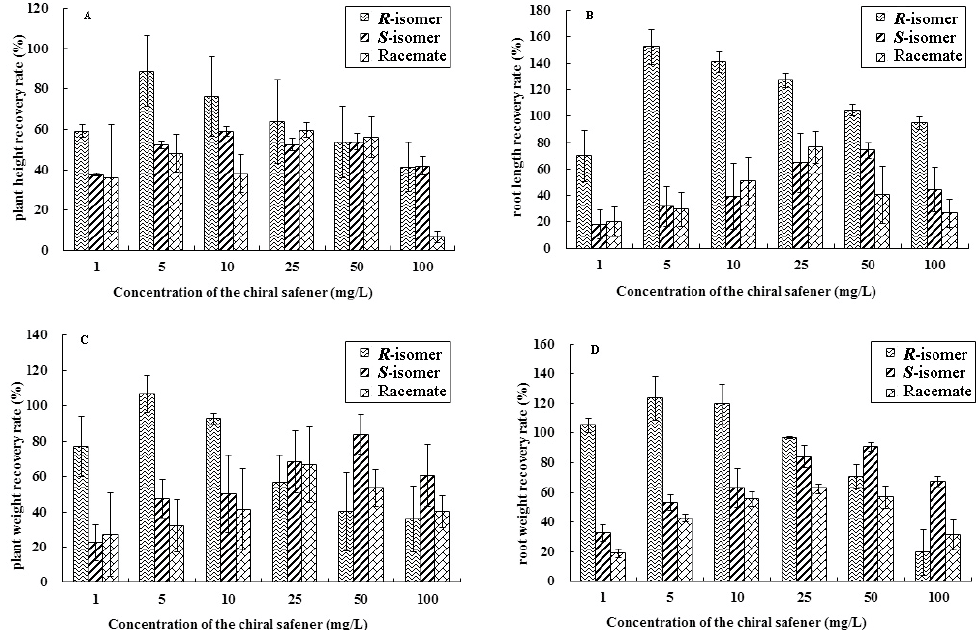
Figure 1. Recovery rates expressed as the growth level of maize treated with chlorsulfuron and safeners.